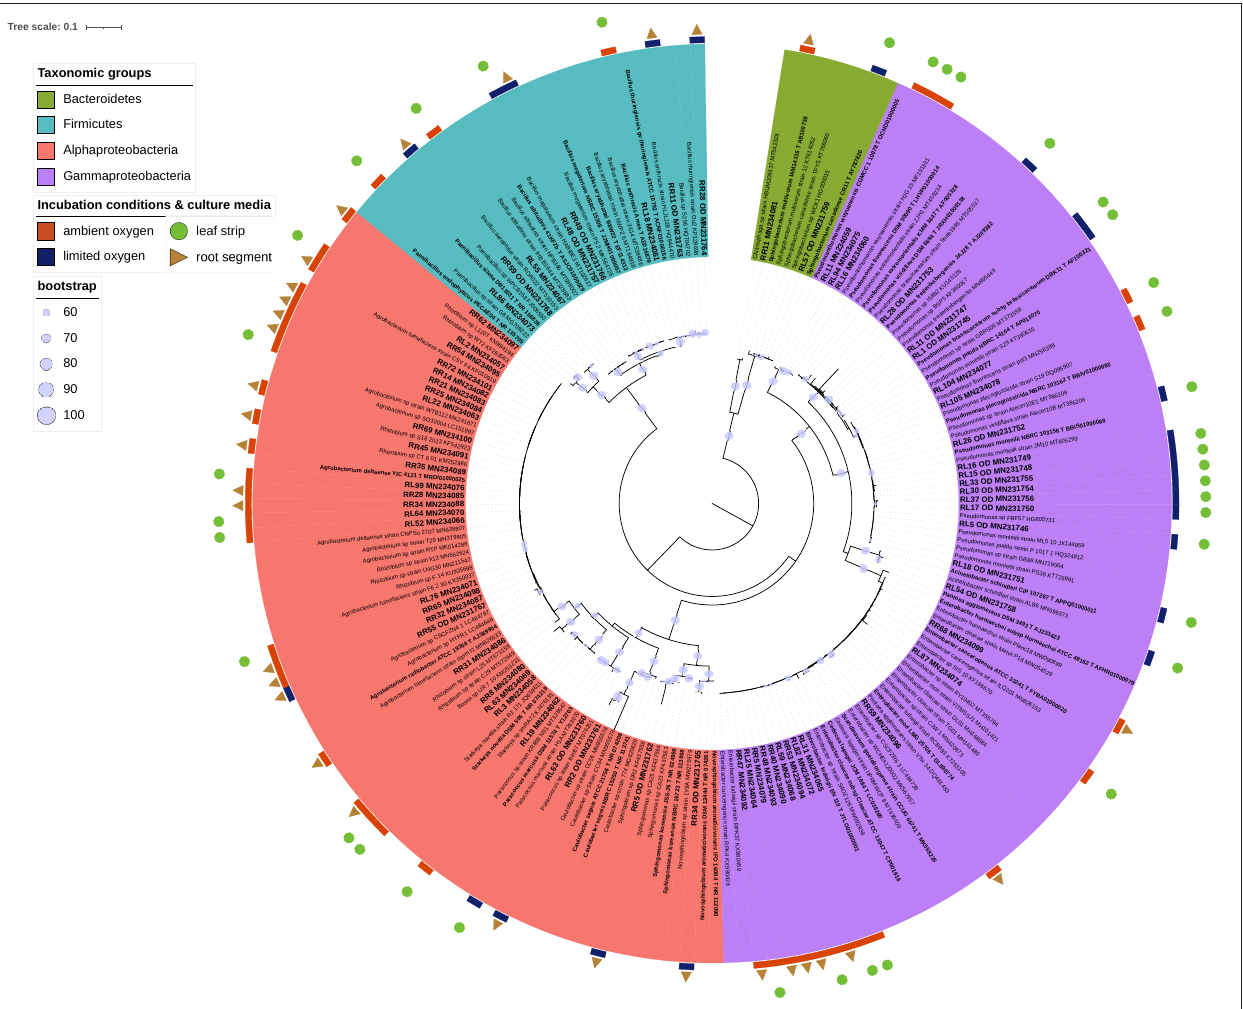
FIGURE 4 | Phylogenetic tree of 16S rRNA gene sequences of the 69 isolates representing endo-rhizosphere of sunflower plants. The colored labels indicate the taxonomic groups (Firmicutes, Alphaproteobacteria, Gammaproteobacteria, Bacteriodetes), incubation conditions (ambient and limited oxygen), and culture media (leaf strips and root segments). Respective isolates identifier followed by their accession number are highlighted in bold and larger font style. In contrast, closely related strains are written in normal style, while type strains are displayed in bold, indicated by a T followed by the accession number. The phylogenetic tree was interfered with the Maximum Likelihood method under the GTRCAT model, using RAxML. The bootstrap values for 1,000 replicates are adorning the branches as